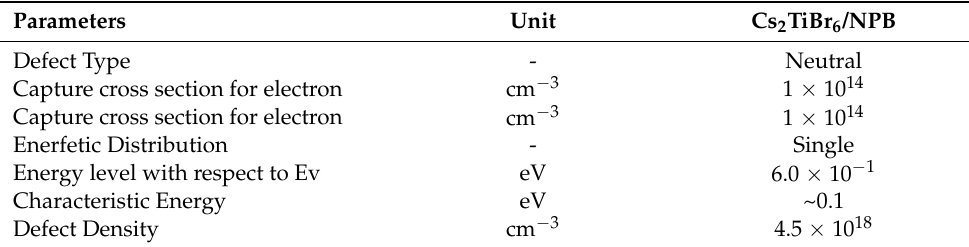
Table 2. Interface traps parameters between the Cs 2 TiBr 6 and NPB